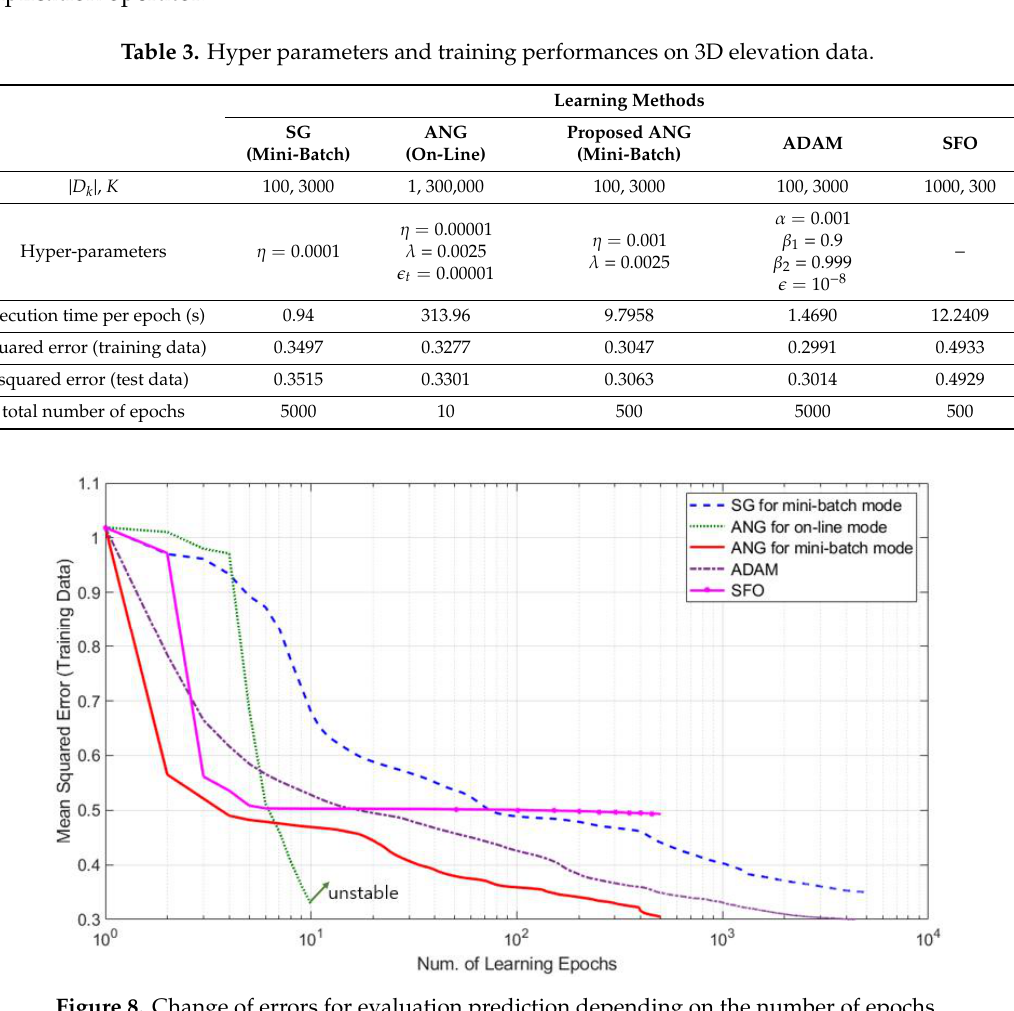
Figure 8. Change of errors for evaluation prediction depending on the number of epochs.